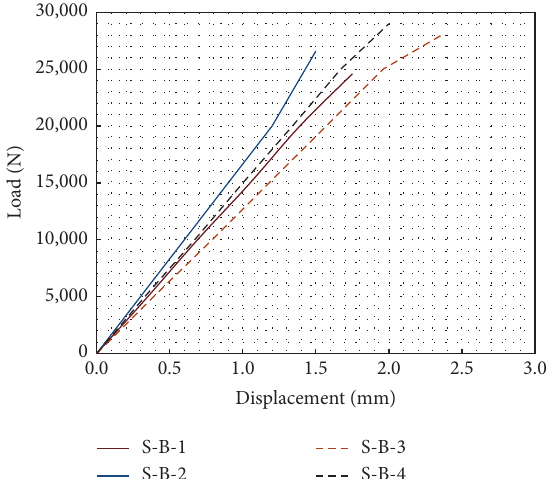
Figure 7: Load-deflection of group B beams.